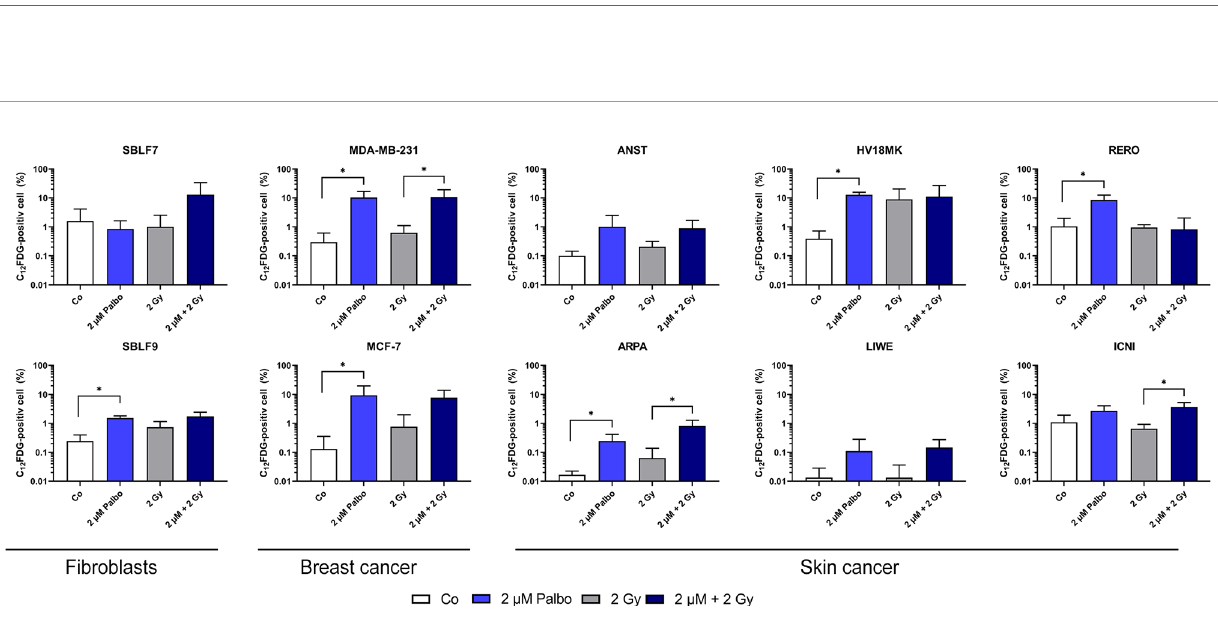
FIGURE 3 | C12-FDG staining as indicator of cellular senescence. Proportion of C12-FDG-positive cells after 10 days of incubation in 10 different cell lines (healthy fi broblast SBLF7 and SBLF9, breast cancer MDA-MB-231 and MCF-7, and skin cancer ANST, ARPA, HV18MK, LIWE, RERO, and ICNI cells). Cells were treated for 24 h and irradiated with a single dose of 2 Gy. Each value represents mean ± SD ( n = 3). Signi fi cance was determined by one-tailed Mann – Whitney U test * p ≤